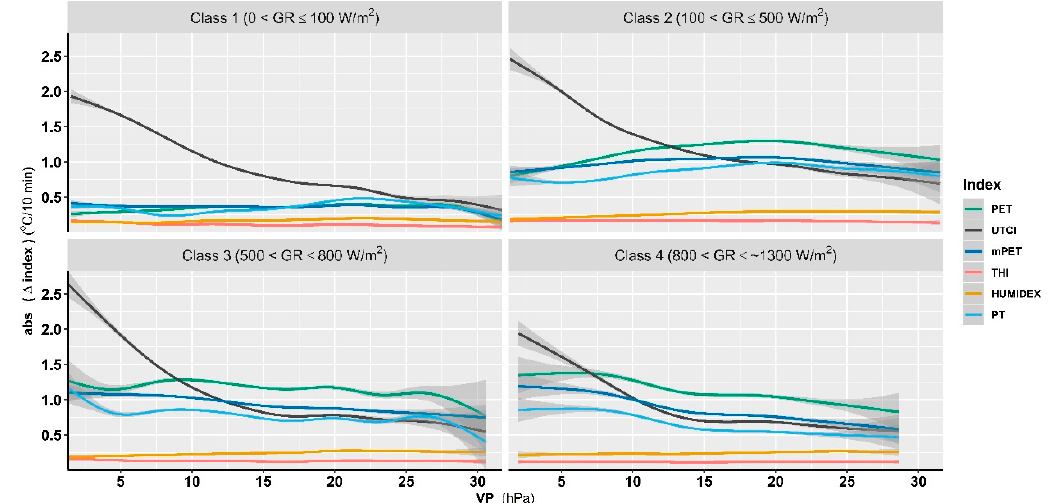
Figure 7. The sensitivity of the indices to vapour pressure (VP) variation under different global radiation (GR) conditions.